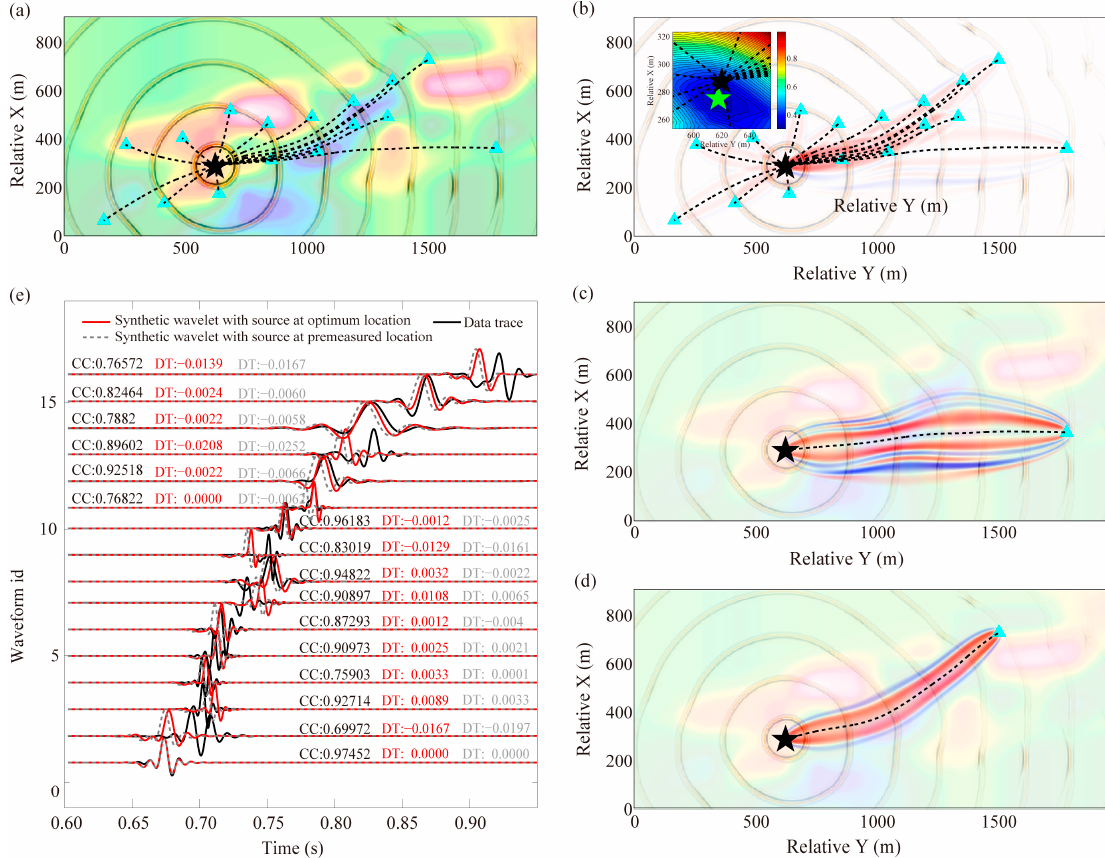
Figure 7. MS-GSWI location results of the blasting event 3. The rest of the explanation is the same as Figure Figure 6.